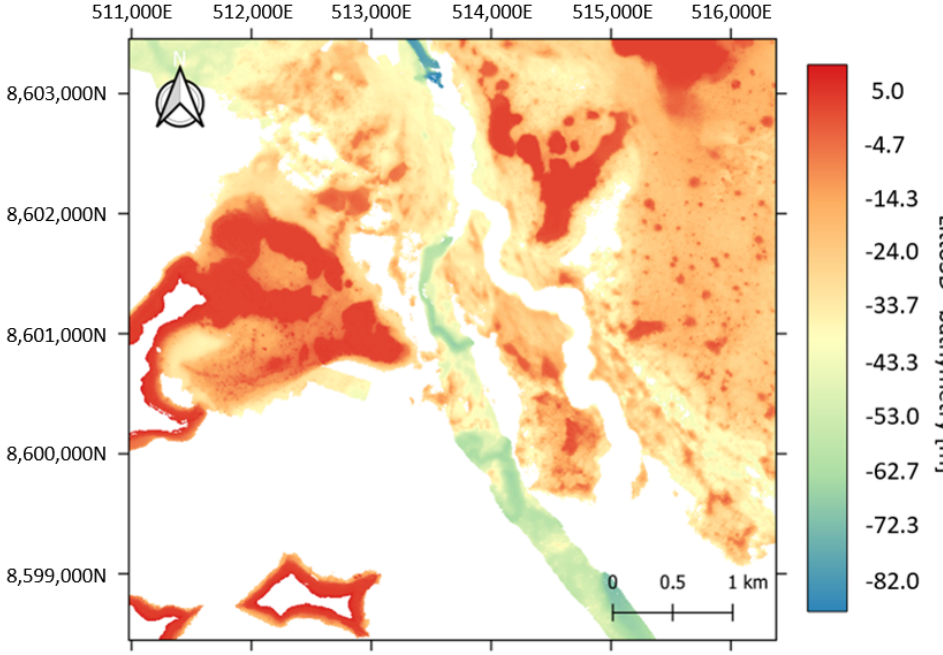
Figure 12. Digital depth model generated from the Litto3D ® dataset acquired over Mayotte and centered on the study site. The land area is masked.